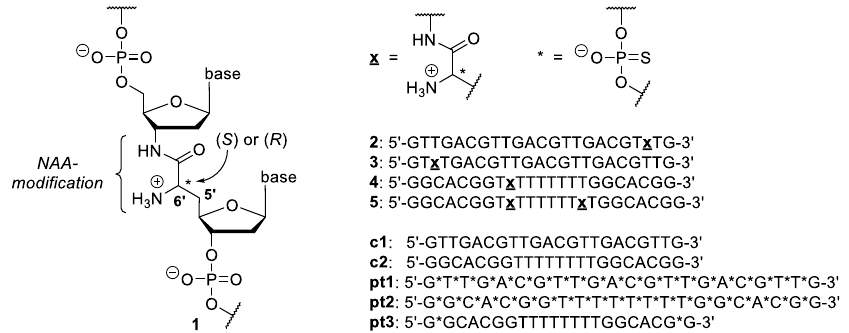
Figure 1. Principle structure 1 of an NAA-modified DNA oligonucleotide with a partially zwitterionic backbone; NAA-modified DNA oligonucleotides 2 – 5 investigated in this study with unmodified controls c1 and c2 as well as phosphorothioate-modified controls pt1 – pt3 (the linkages not highlighted are phosphate diesters; all sequences are 2′-deoxy).